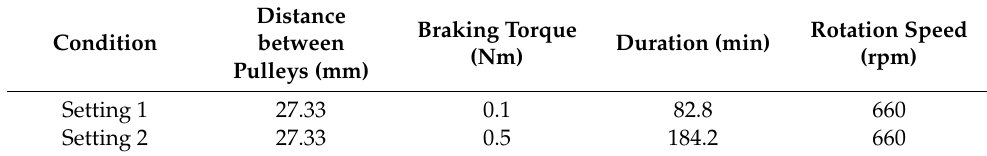
Table 2. Operating conditions implemented during the collection of the Training Data.